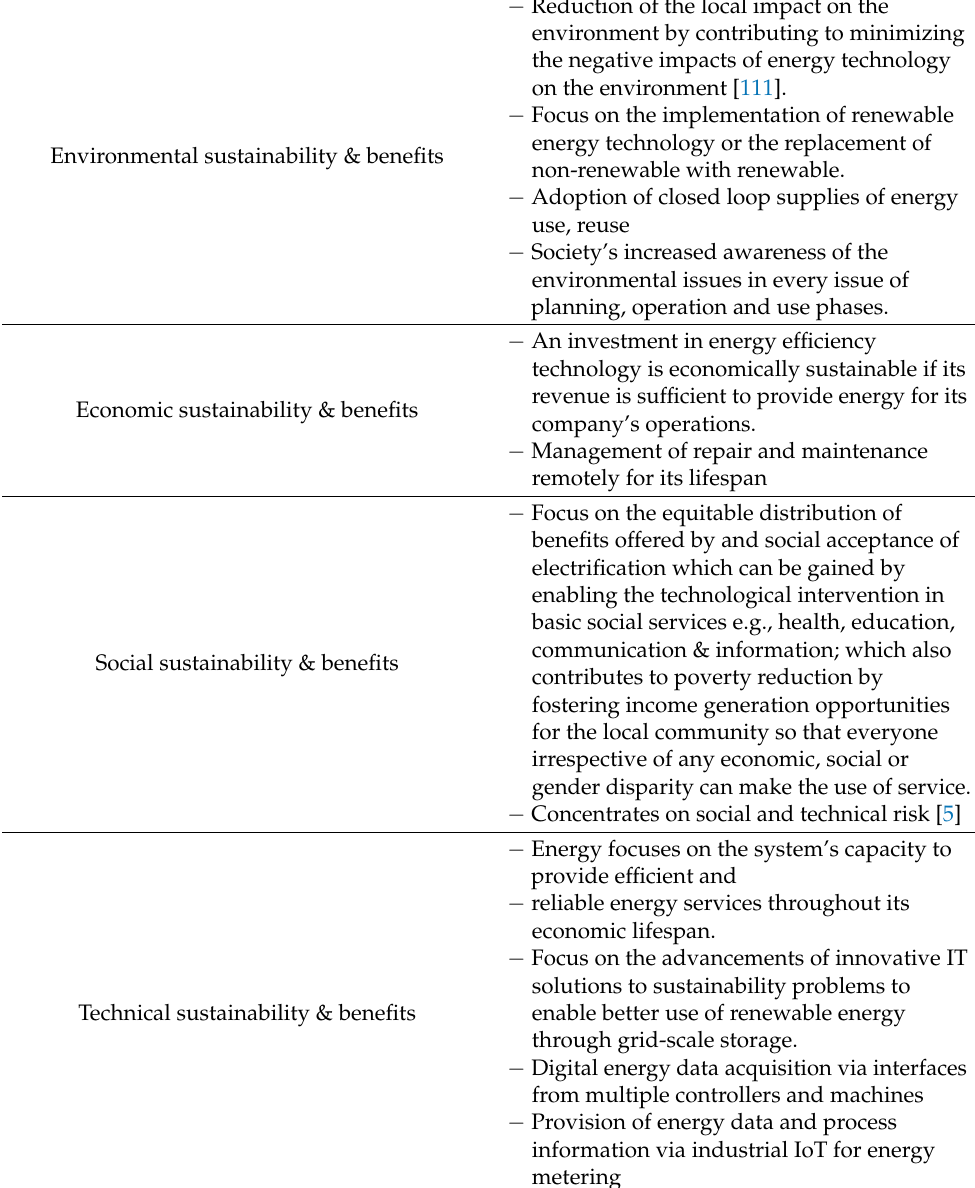
Table 4. Assessment criteria of energy technology options for energy sustainability-based Industry 4.0 in terms of the four sustainability